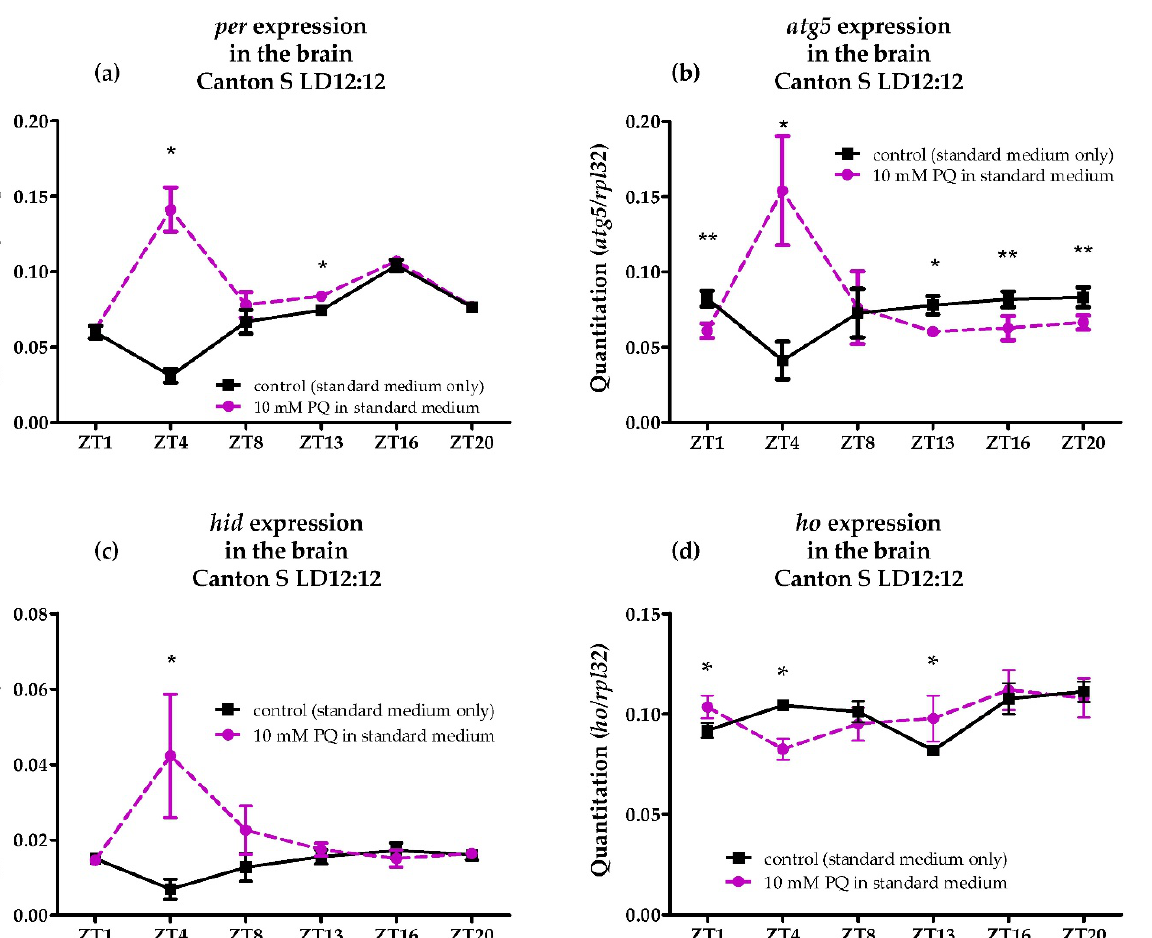
Figure 4. Effects of chronic curcumin supplementation on the mRNA level of heme oxygenase ( ho ) ( a ), apoptosis activator head involution defect ( hid ) ( b ) and sickle ( skl ) ( c ), and autophagy-related 5 ( atg5 –( d ) and atg10 -( e ) genes in the brain of adult males of Drosophila melanogaster . Data shown as means ± SD. Statistically significant differences between groups are indi- cated with asterisks ( p < 0.05).